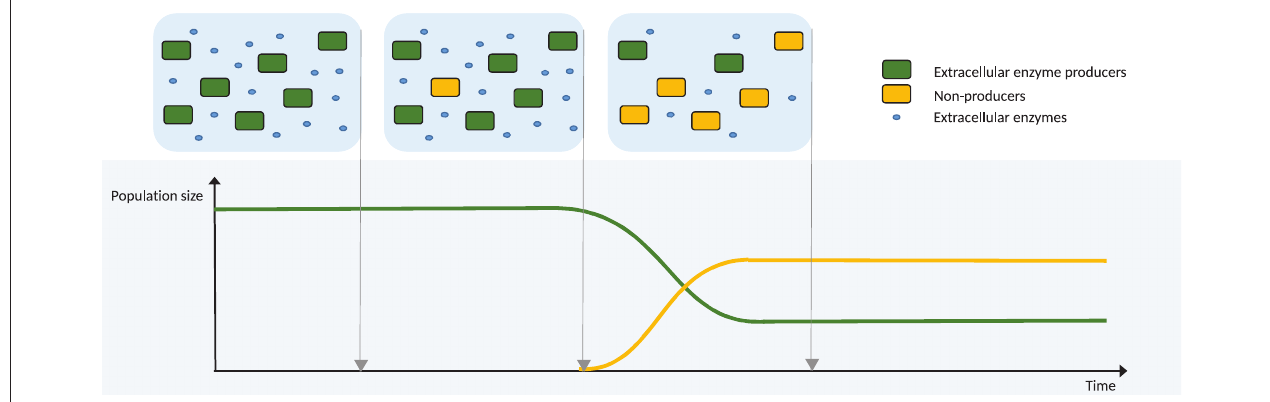
FIGURE 3 | Diagrammatic example of evolution via the Black Queen Hypothesis, where the function lost is the production of an extracellular enzyme for the degradation of a complex molecule. Initially, all bacteria produce the extracellular enzyme, resulting in an abundance of available breakdown products. Mutation produces an individual unable to synthesise this enzyme, therefore giving it a growth advantage via energy saving, but making it entirely dependent on the ancestor. The mutant proportion of the population increases until, at some critical point, the population growth of the mutants is halted, since the reduced overall enzyme production by the population results in reduced availability of breakdown products. The enzyme producers are maintained via negative frequency dependent